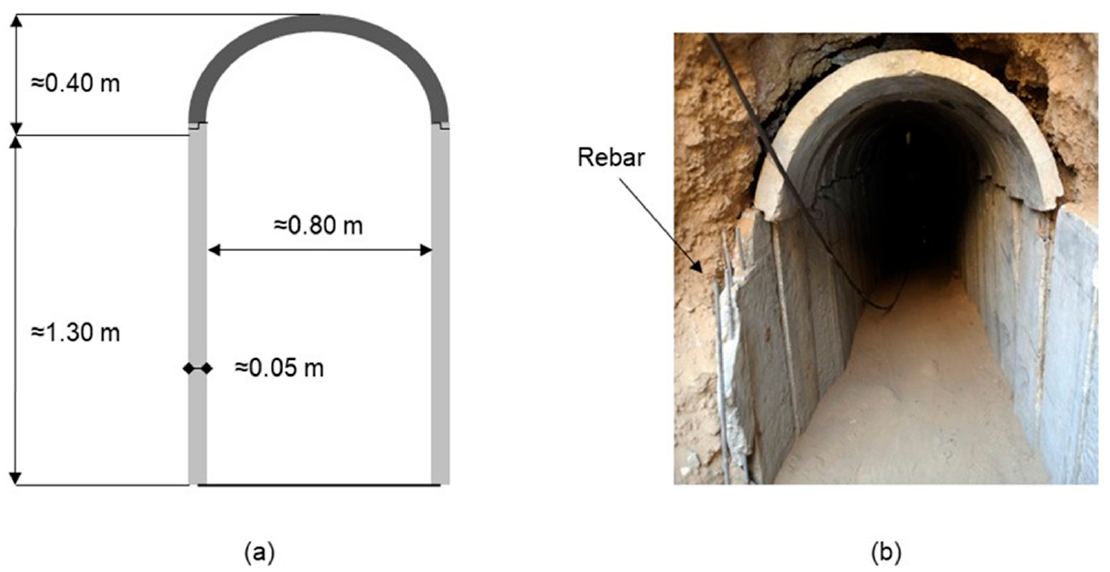
Figure 1. Dimensions of a typical Gaza tunnel. ( a ) estimated concrete segment dimensions, and ( b ) actual field photo (David Buimovitch/AFP/Getty Images).